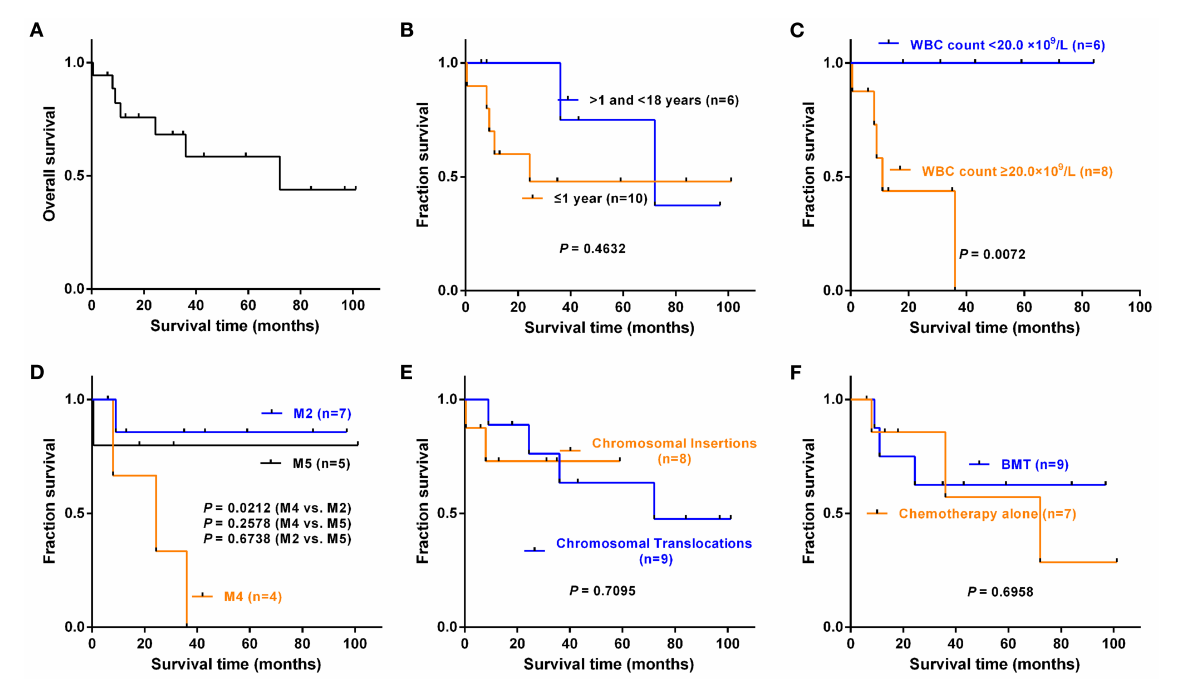
FIGURE4 Kaplan–Meier survival analysis of eighteen cases with complete follow-up information. These included fourteen reported cases with clinical follow-up and four cases in our series. (A) Overall survival of eighteen cases. (B) Infant group ( ≤ 1 year) vs. pediatric group ( > 1 and < 18